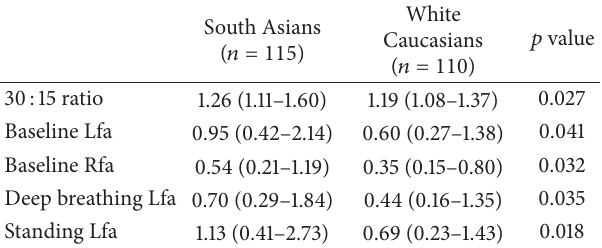
Table 5: Assessment of microvascular blood flow and endothelial functioninSouthAsiansandWhiteCaucasianswithtype2diabetes. Data presented as median (IQR) or ratios. Blood flux was measured in arbitrary perfusion units (APU). Conductance is the measure of dividing flux by the mean arterial